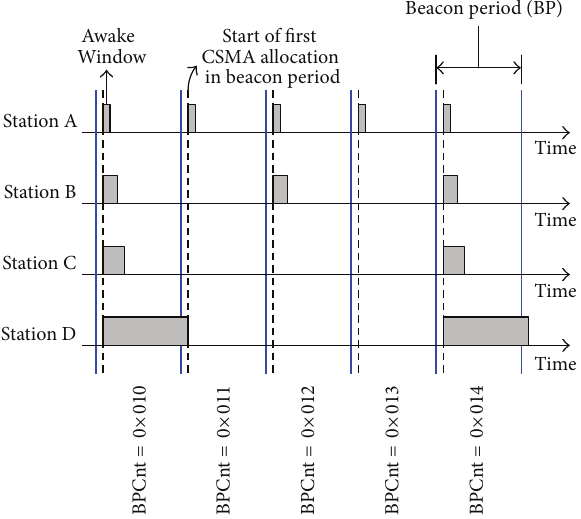
Figure 18: Example of Power Save operation in HomePlug AV2 and HomePlug Green PHY.